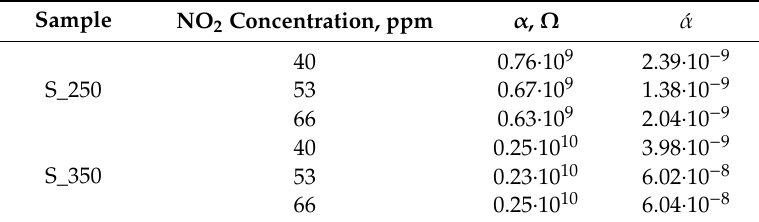
Table 1. Values of constants from the Elovich plot.